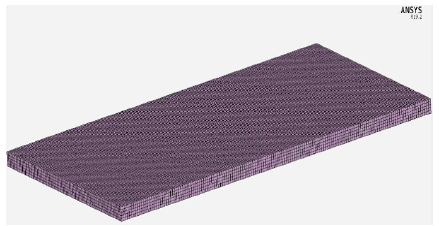
Figure 10. FEM mesh for aluminium alloy plate (approx. 200,000 hexahedral elements).